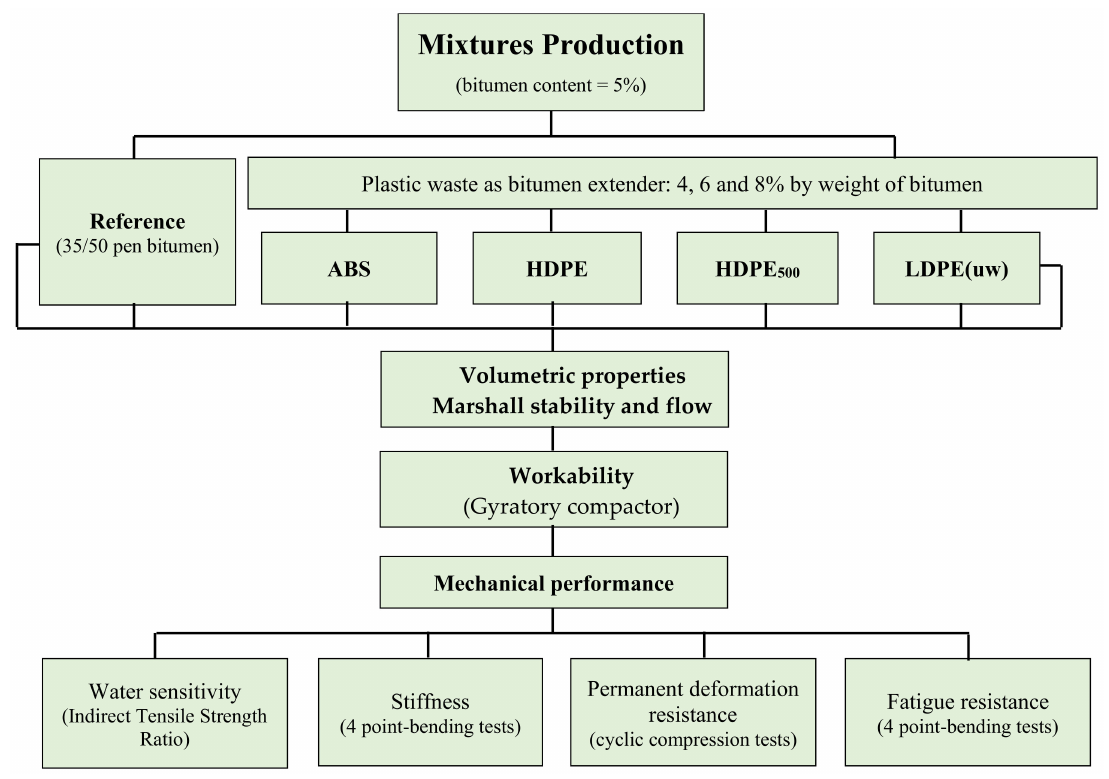
Figure 3. Experimental plan carried out in the